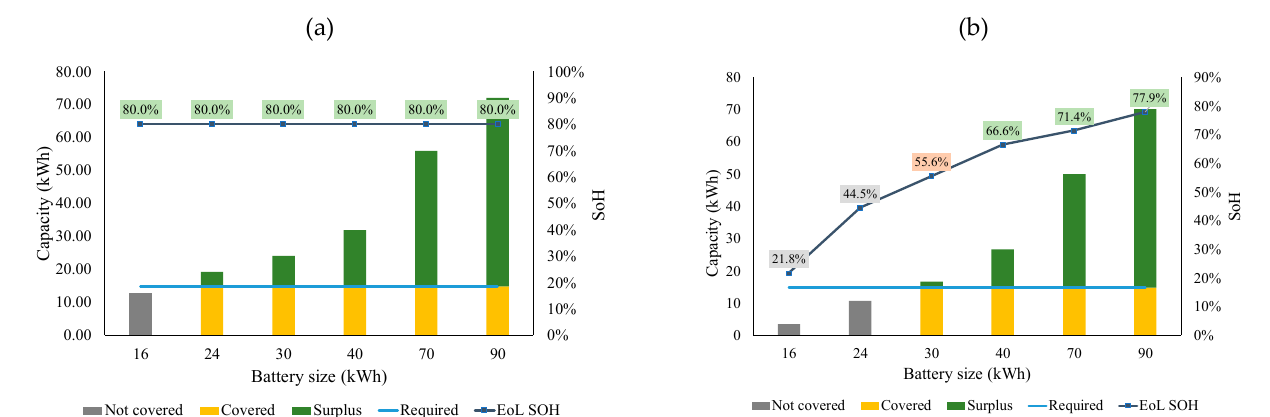
Figure 3. EoL capacity for 16 to 90 kWh batteries considering: ( a ) a fixed threshold and ( b ) a functional threshold.